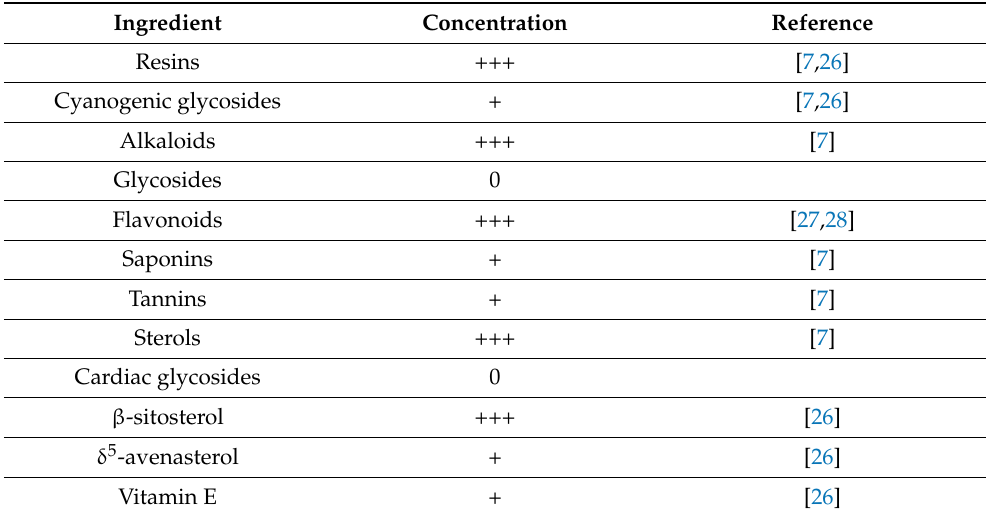
Table 2. Main active substances of cultivated Cyperus ( Cyperus esculentus L.)